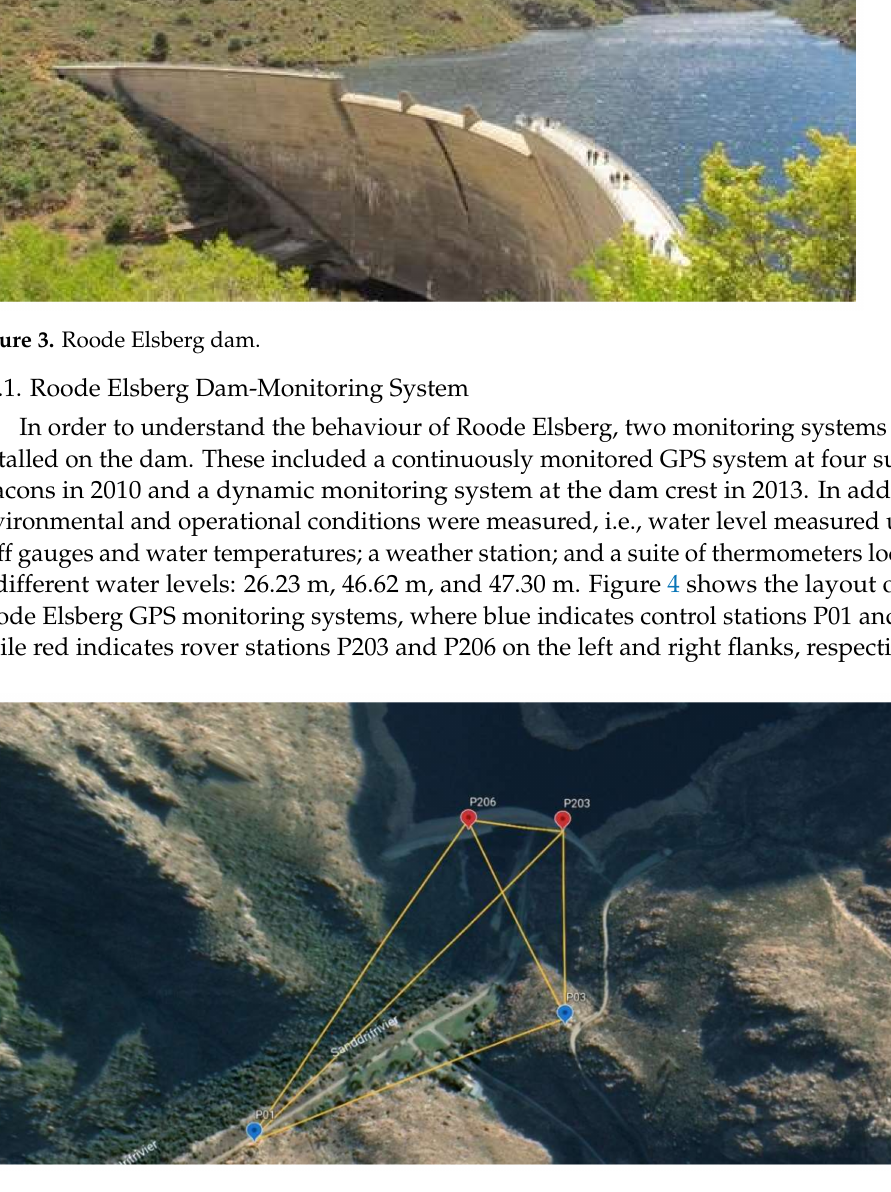
Figure 4. Roode Elsberg GPS monitoring